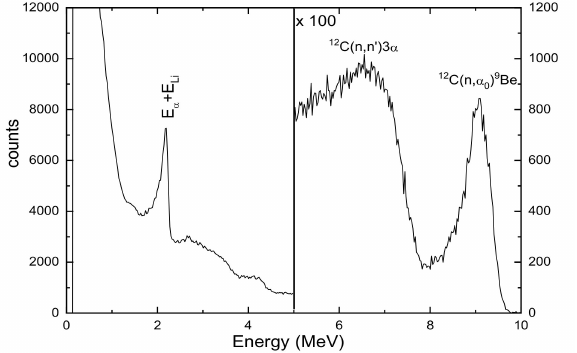
Figure 19. Typical PHA spectrum recorded by diamond detector in “sandwich” configuration using B 2 O 3 as the conversion